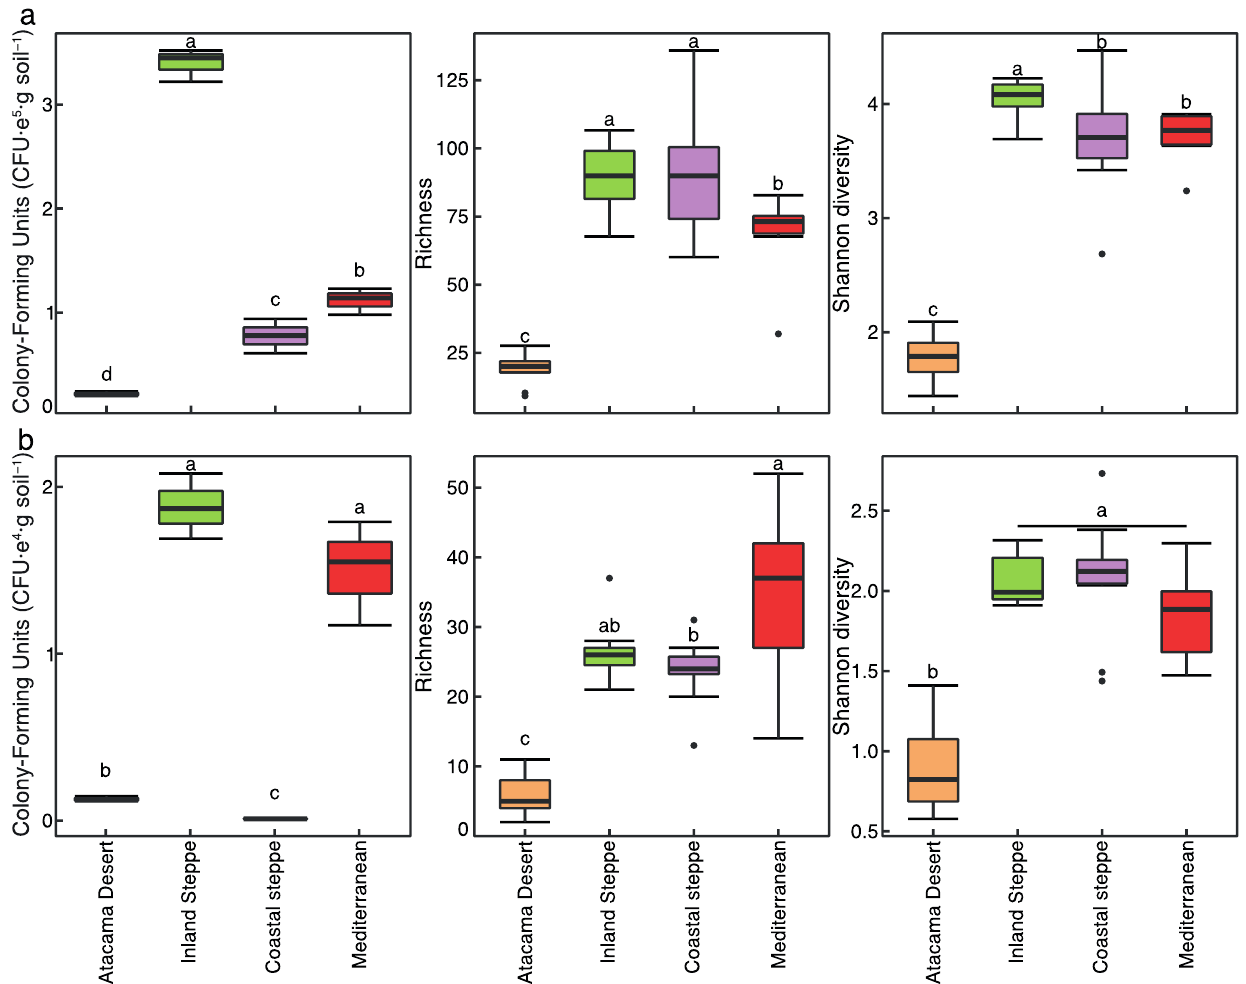
Figure 3. Boxplot of bacterial ( a ) and fungal ( b ) Colony-Forming units, Richness and Shannon diversity index of soil samples, colored by location. Lowercase letters in the upper part of the boxplot represent Fisher’s least significant difference (LSD) when α = 0.05 from Kruskal–Wallis testing differences between soils. Whiskers represent 1.5× inter-quartile range (IQR). Dots correspond to outliers.